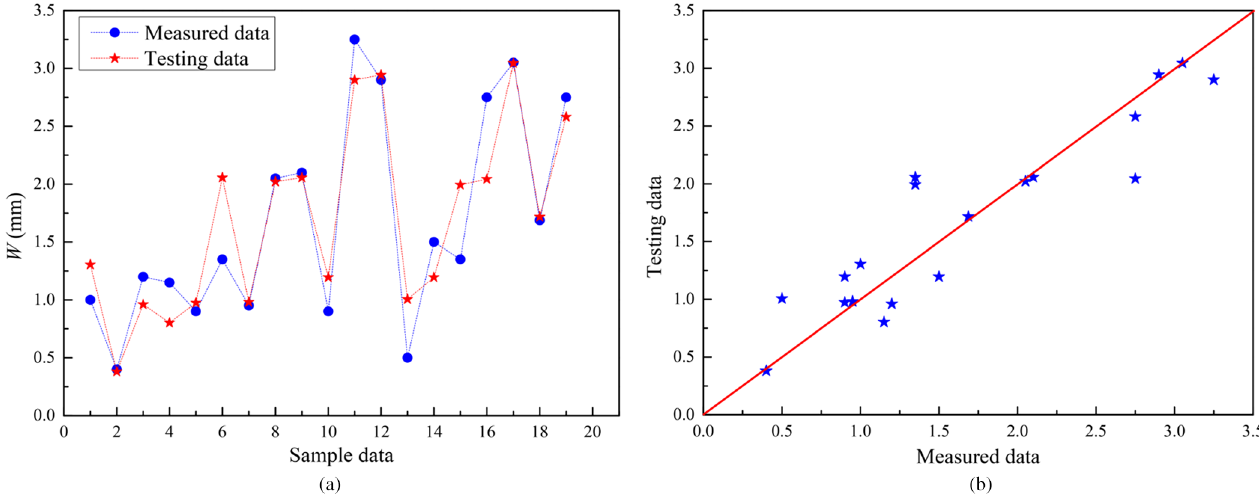
Fig. 7. The BPNN testing results of the cylinder liner wear. (a) Comparison of testing and measured data on the testing set. (b) Performance of BPNN on the testing